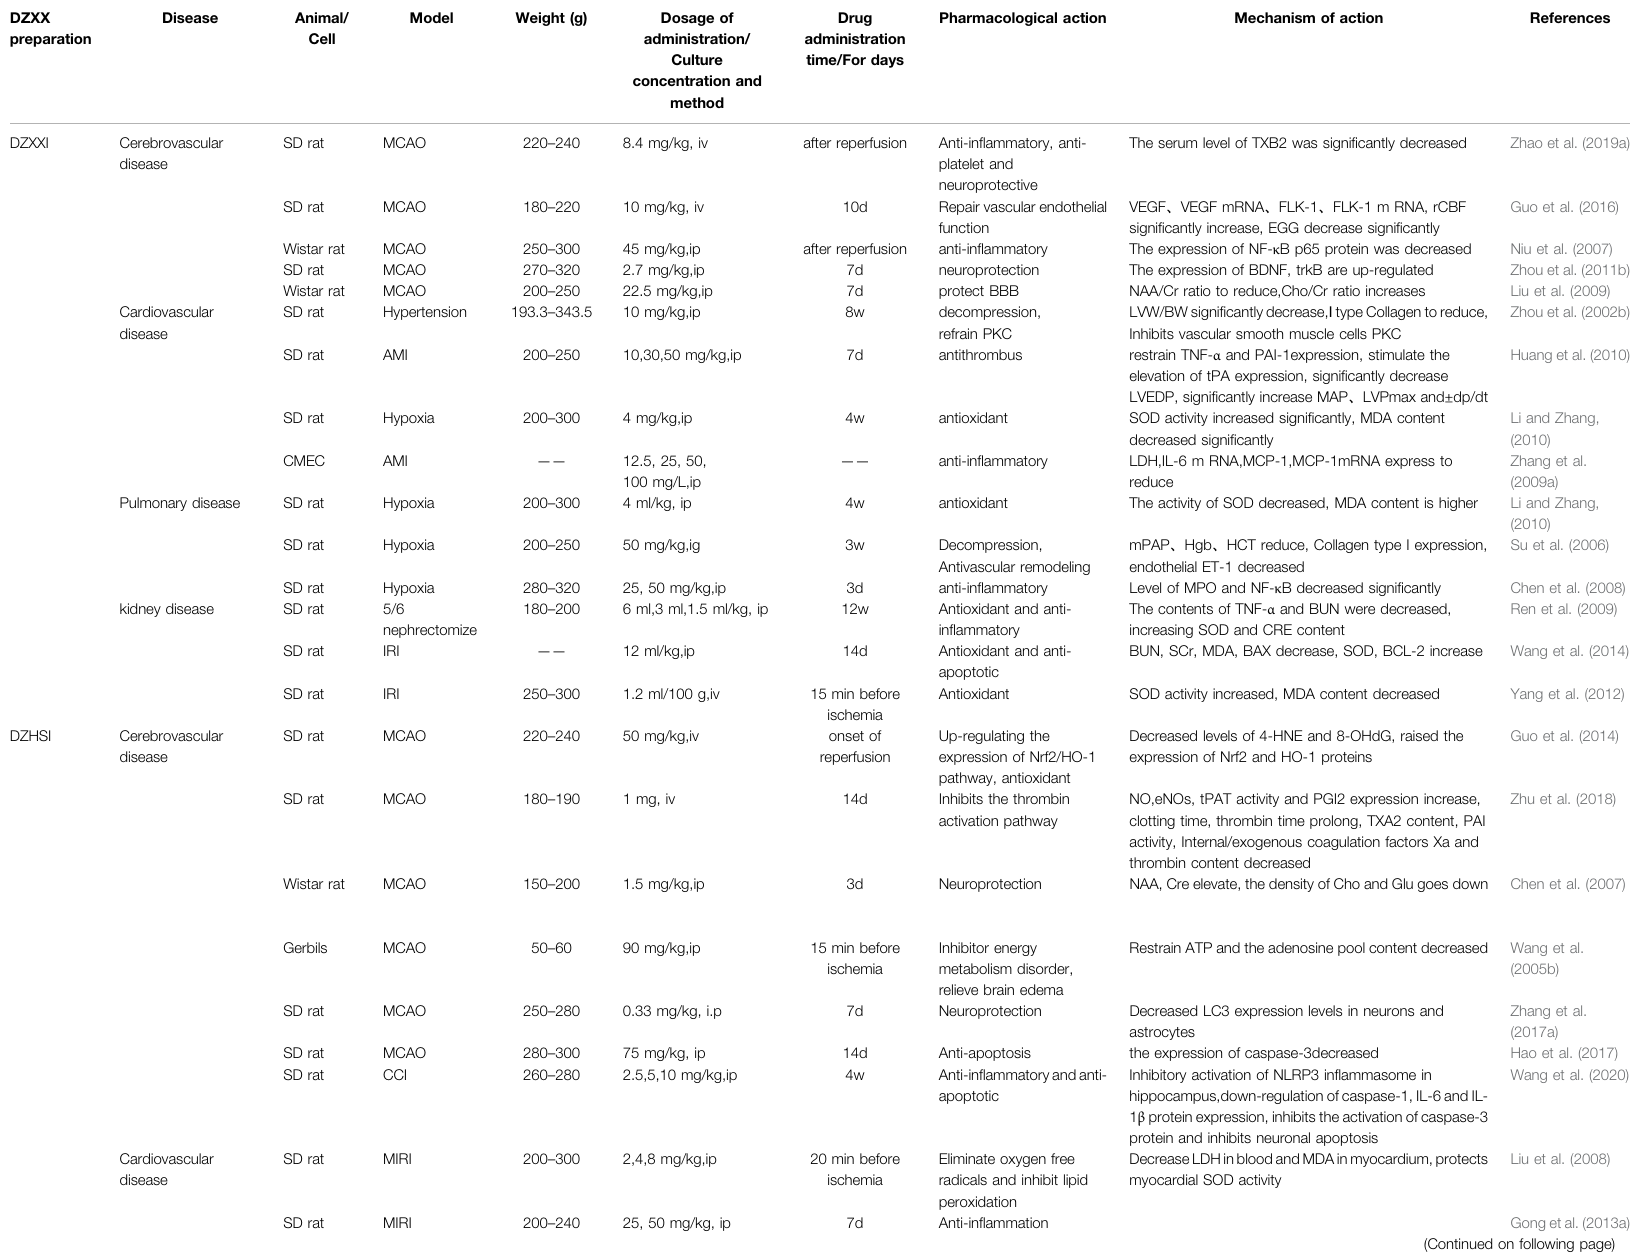
TABLE 4 | Pharmacological Effects of DZXXI preparations in various